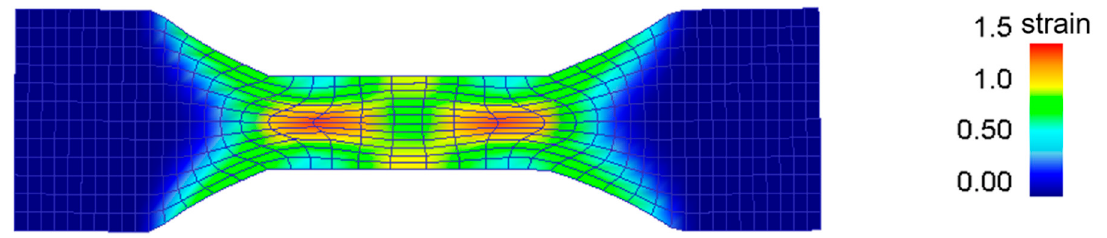
Figure 3. Finite element simulation using DEFORM TM 2D showing the strain distribution within the plane strain sample after cold deformation at a nominal strain of 1.